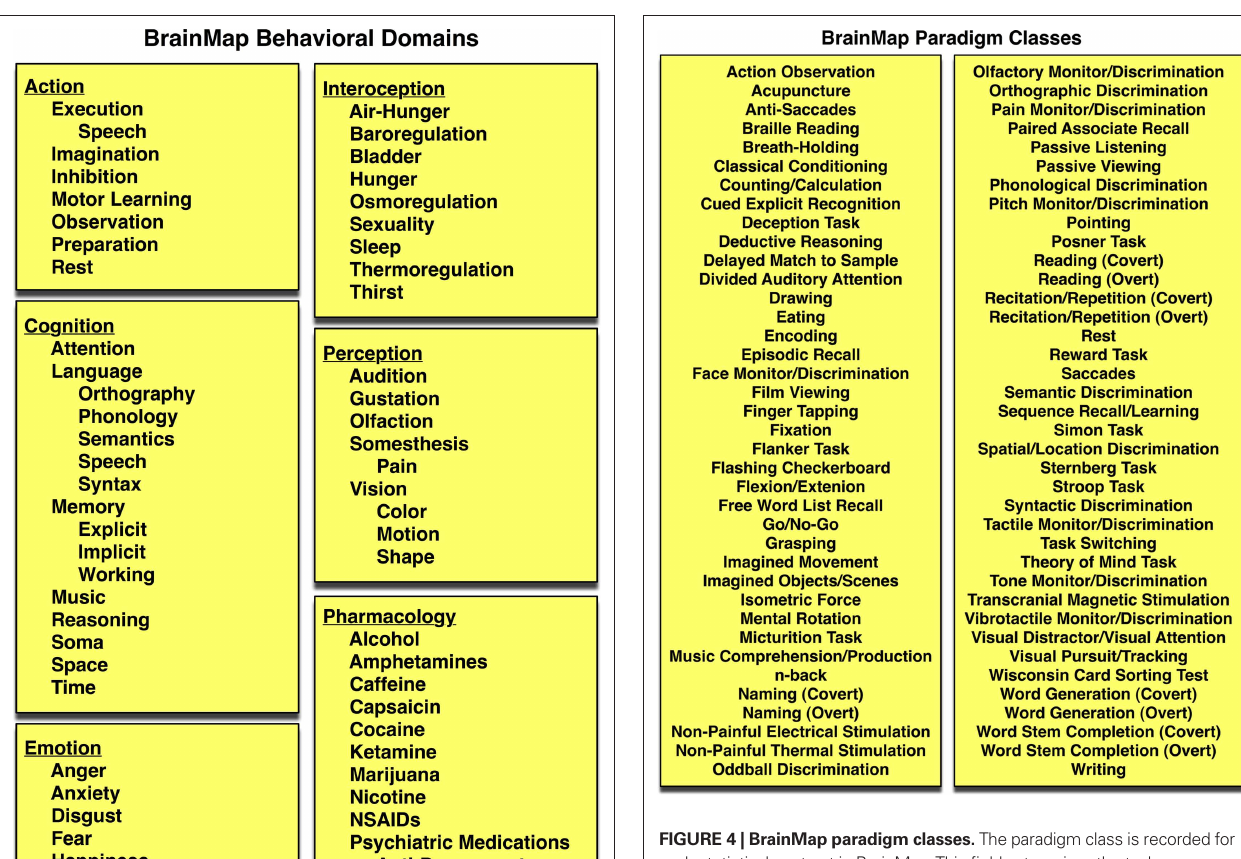
FIGURE 4 | BrainMap paradigm classes. The paradigm class is recorded for each statistical contrast in BrainMap. This fi eld categorizes the task or challenge presented, preferably in the jargon of the fi eld. BrainMap currently contains 80 paradigm classes. The yellow background represents that this fi eld lies at the Experiment